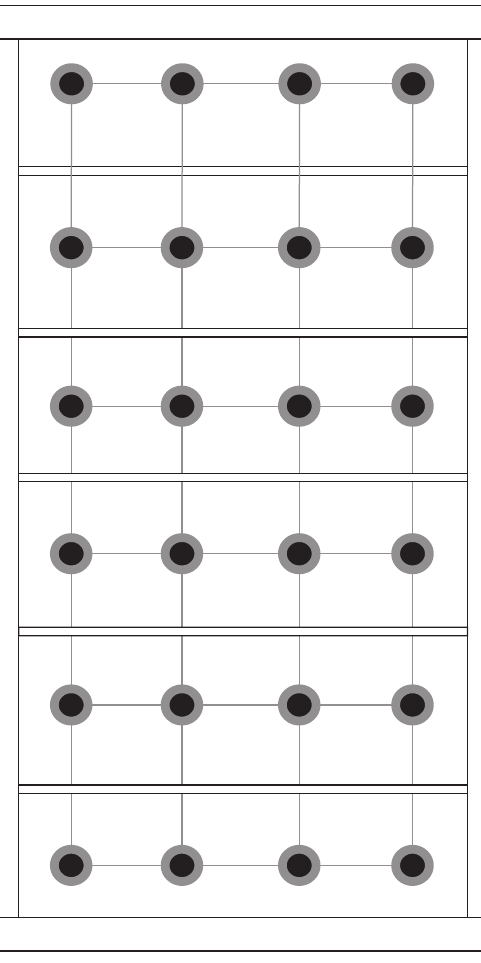
Figure 4: Communication topology of the air-conditioning controller. Table 2: Selection of air-conditioning